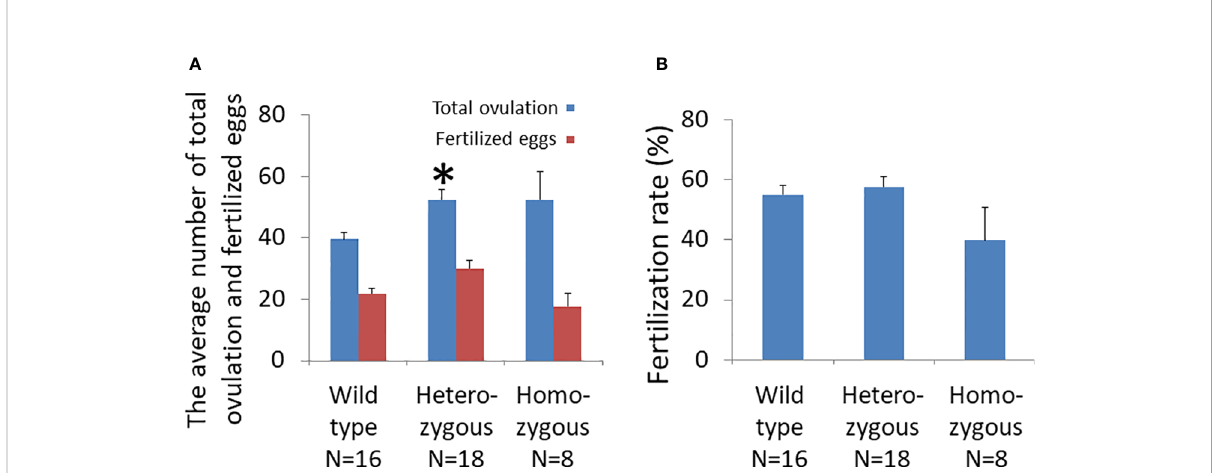
FIGURE 3 Effects of oocyte-speci fi c Adm2 disruption on ovulation rate following superovulation. (A) The numbers of ovulated oocytes and fertilized eggs of wild-type ( Adm2 +/+ /Zp3 -Cre, N=16), heterozygous ( Adm2 +/- /Zp3 -Cre, N=18), and homozygous ( Adm2 -/- /Zp3 -Cre, N=8) mice are represented by blue and red vertical bars, respectively (mean ± SEM). Ovulated oocytes were collected at 46 hr after hCG injection. The homozygous animals had a higher number of ovulated oocytes compared to wild-type mice, and the difference was at the border of signi fi cance ( p = .08). (B) The fertilization rate of ovulated eggs (mean ± SEM). The fertilization rate ranged from 39.8 ± 11.0% in homozygous females to 57.4 ± 3.4% in heterozygous females. * , signi fi cantly different from the wild-type at p <